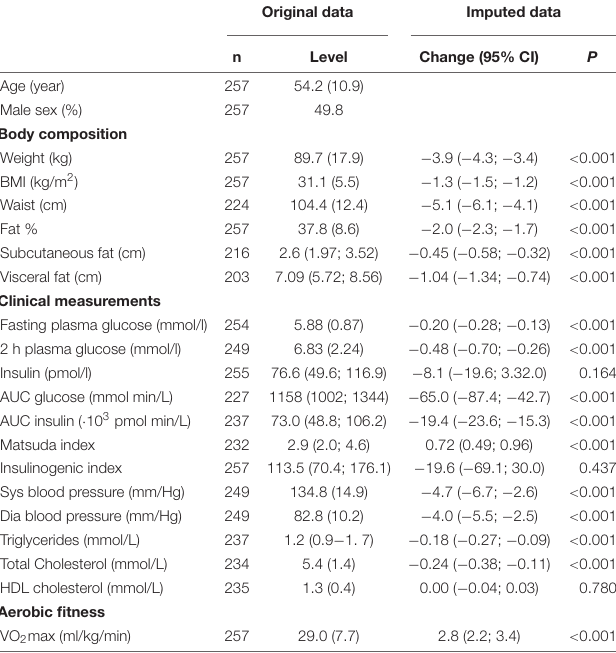
TABLE 1 | Baseline characteristics of the study population (original data) and estimated impact of intervention (imputed